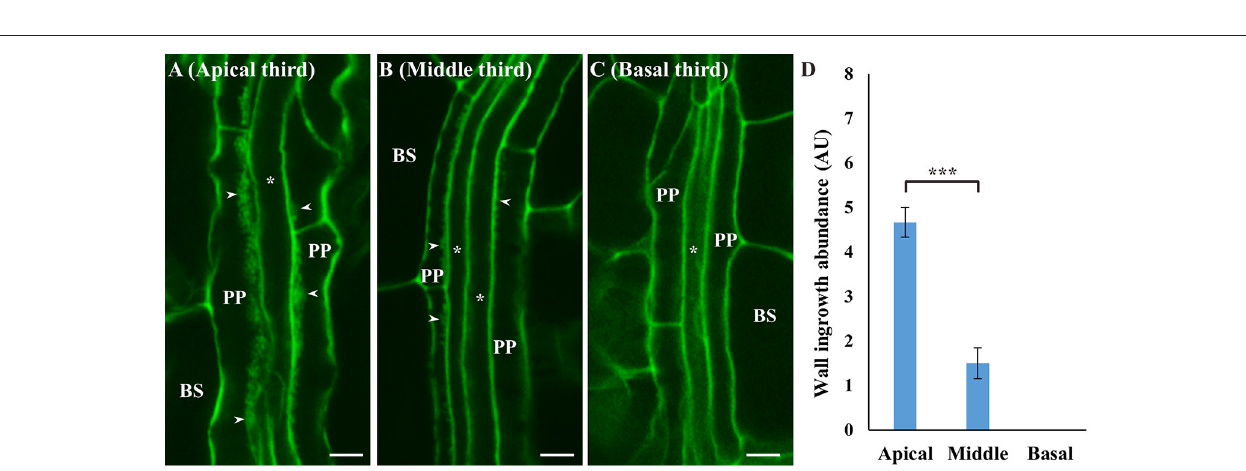
FIGURE 4 | Deposition of wall ingrowths in PP TCs of minor veins in apical, middle and basal regions of rosette Leaf 12 at day 31. Thick stretches of wall ingrowth deposition can be seen in PP TCs in a minor vein in the apical third of the leaf (A) , with less abundant deposition in the middle third of the leaf (B) , and no wall ingrowths seen in PP cells in the basal third of the leaf (C) . BS denotes bundle sheath cells; asterisks indicate SE/CCs; PP denotes either PP or PP TCs as appropriate; arrowheads indicate wall ingrowths. Scale bars = 5 µ m. (D) Semi-quantitative analysis of wall ingrowth deposition showed that wall ingrowth abundance significantly decreased from the tip (apical) to the base (basal) of the leaf. Data shows mean ± SE of scores for wall ingrowth deposition in arbitrary units. *** P < 0.001, student’s t -test, n > 6).